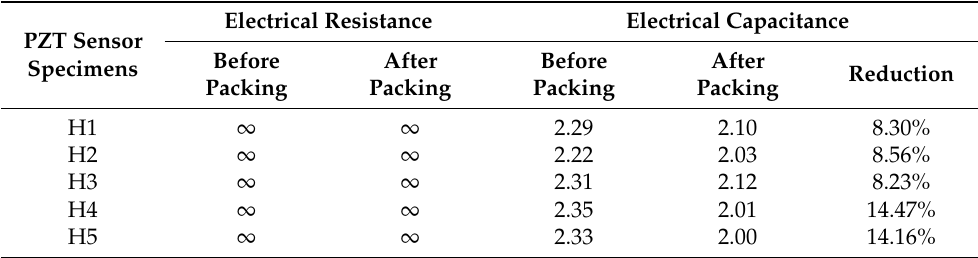
Table 1. Electrical resistances and capacitances of PZT sensors before and after packing.